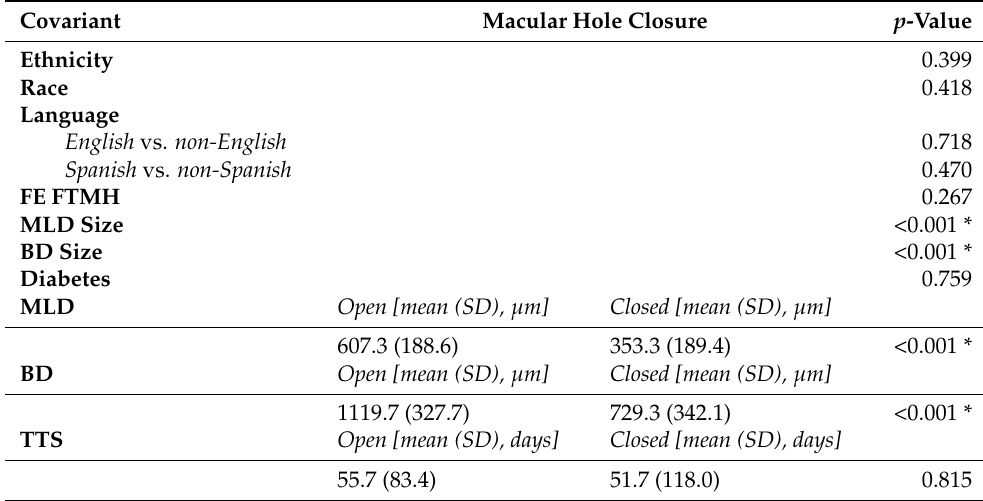
Table 7. Macular hole closure following surgery categorized by ethnicity, race, language, FE FTMH, MLD size, BD size, diabetes status, mean MLD, mean BD, and mean time to surgery.